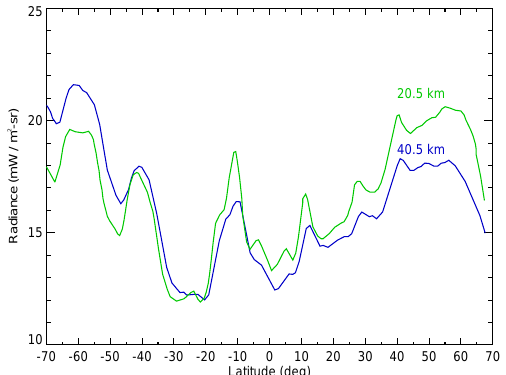
Figure 2. The 350nm sun-normalized radiances from one orbit of OMPS LP (center slit) taken on 2 February 2012. The blue line shows 40.5km values, and the green line shows 20.5km values (di- vided by 8 to put both curves on a similar scale) versus latitude. Since the global aerosol loading on this day was small, the short- scale features in both curves are largely caused by variations in cloud and surface albedo. The 20.5km curve has sharper features and appears to be shifted toward the South Pole. This is because large Rayleigh attenuation at 20.5km causes the radiances to have much higher sensitivity to the atmosphere on the satellite side of the tangent point (TP), while 40.5km radiances have similar sen- sitivities to both sides. This effect creates large noise in applying the RSAS technique to orbital data. However, since the noise varies randomly from orbit to orbit, it can be reduced by averaging data from multiple orbits.